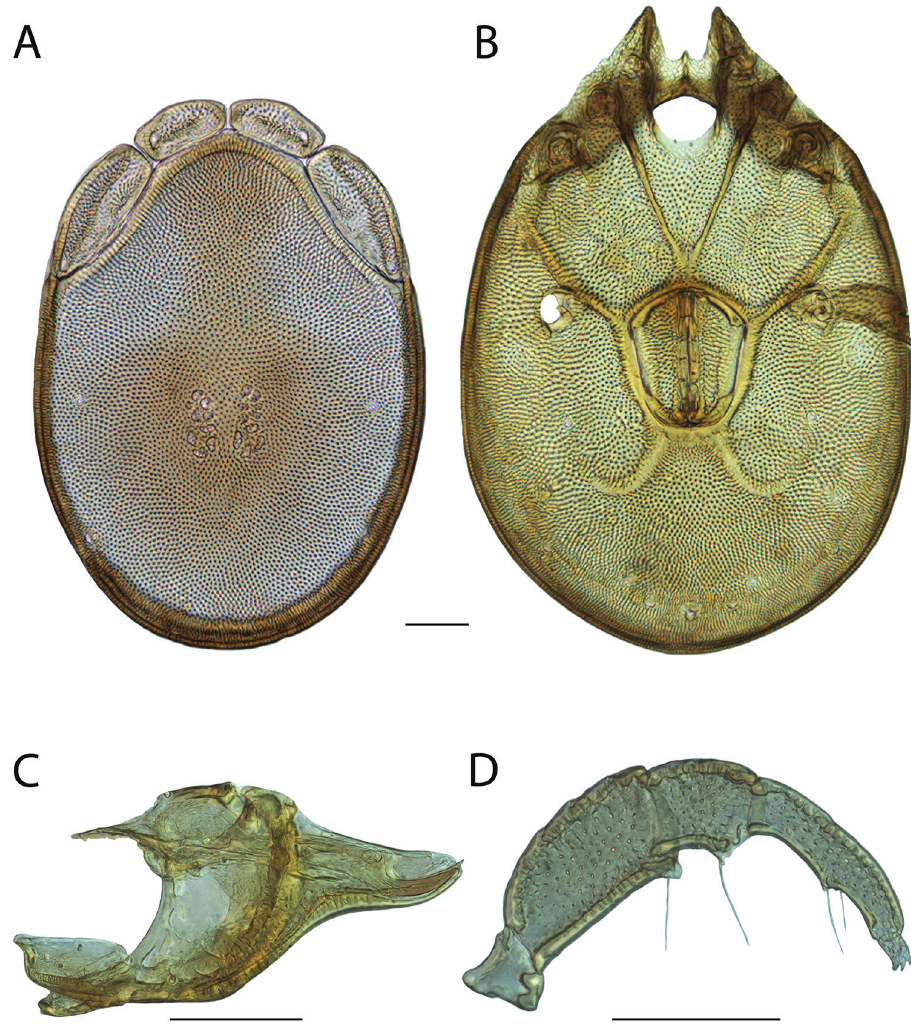
Figure 130. Torrenticola leviathan sp. n. female: A dorsal plates B venter (legs removed) C subcapitulum D pedipalp (setae not accurately depicted). Scale = 100